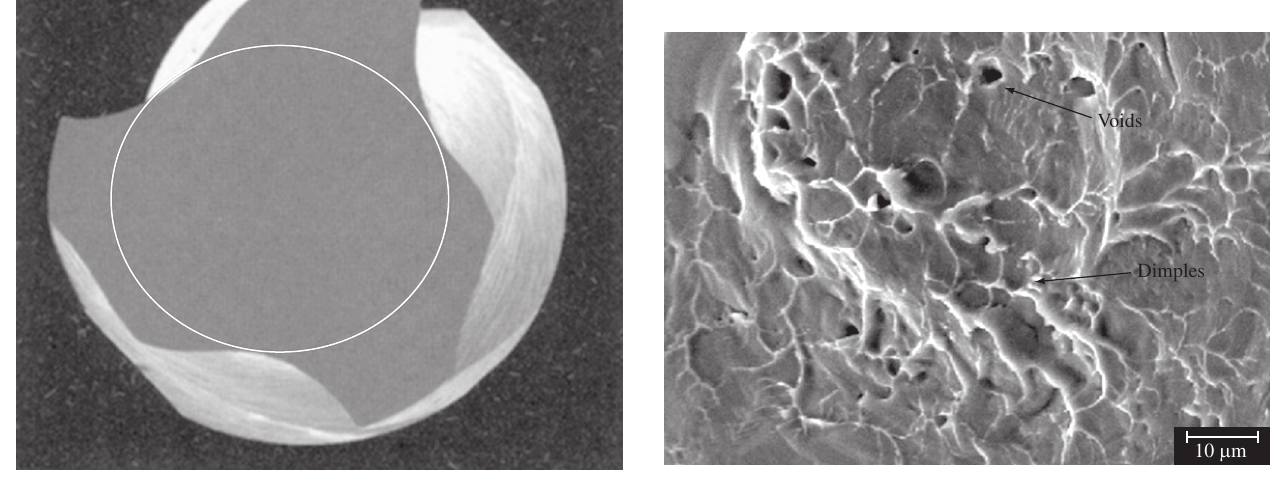
Figure 3. Representation of the K 3 Endo instrument with triple helix cross section (Lopes et al. 20 ).